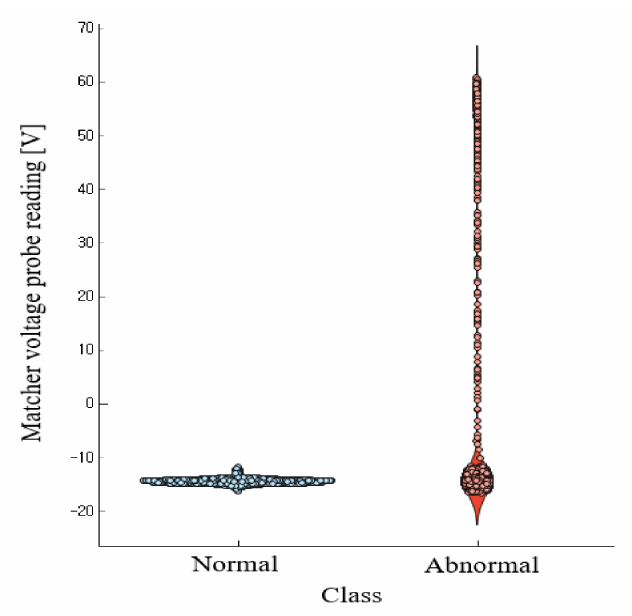
Figure 6. Data distributions of the matcher voltage probe readings using a violin